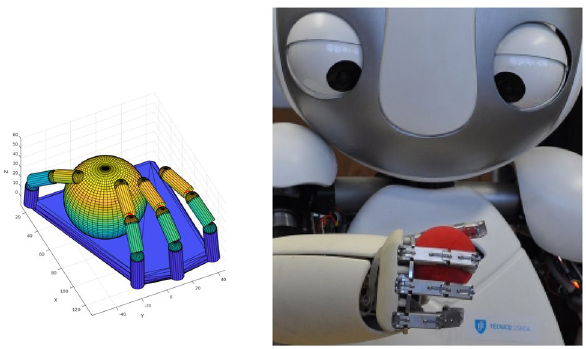
Fig. 1 Vizzy’s hand grasping a ball in simulated environment (left) and the actual robotic hand grasping a ball